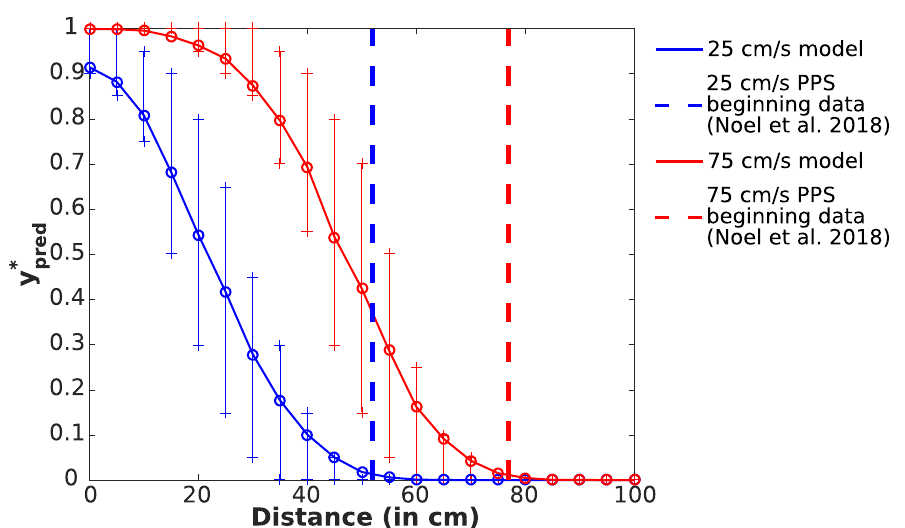
Fig 5. Comparison of PPS sizes for object velocities of -25 and -75 cm/s. Dependency between the mean of 1000 repetitions of impact predictions y � and distance x (in centimeters) between the stimuli and body, for different T pred object velocities. The symbol “+” indicates 25th and 75th percentiles which are calculated from 1000 predicted values for each distance. Notice that the beginning of PPS—defined as the farthest distance for which y � pred Þ > 0 : 01 —roughly corresponds to the PPS beginning around the face determined by [14]. Except for the mean ð y � pred velocity v = − 75 cm / s ,the baseline parameters from Table 1 are used. See S3 Fig for a version with FN = FP = T